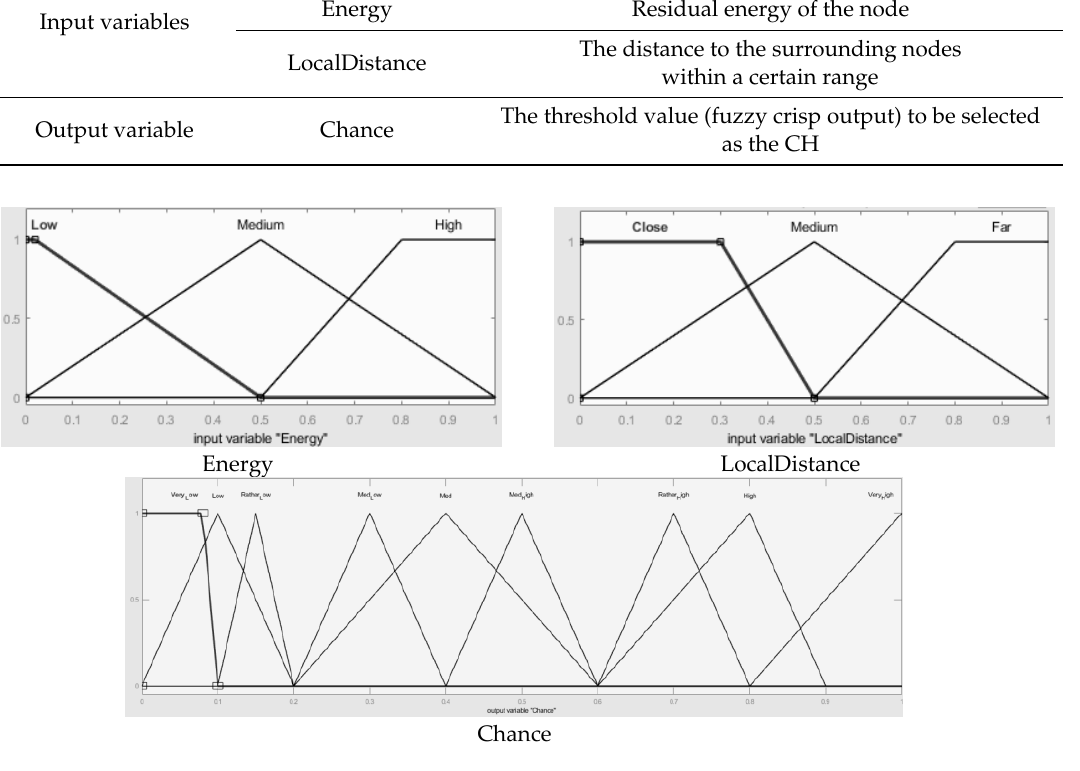
Figure 6. Membership functions of inputs and output in the first FIS. Electronics 2020 , 8 , x FOR PEER REVIEW